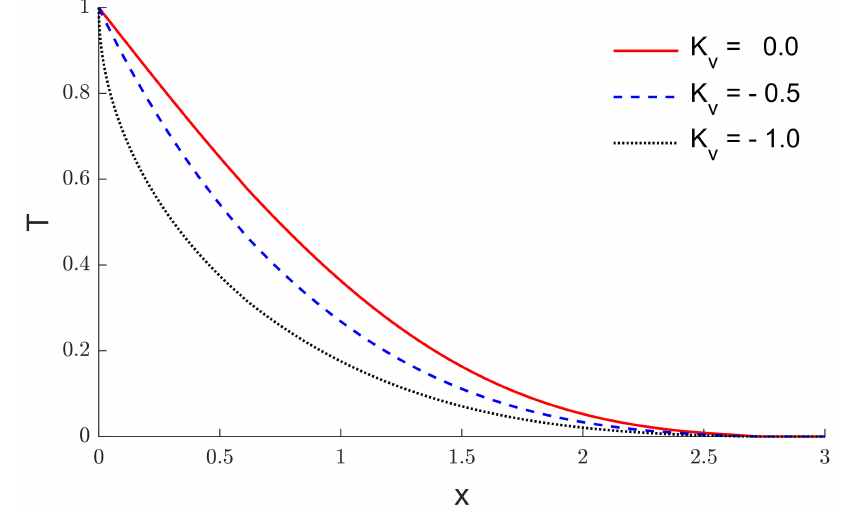
Figure 1. The temperature variation along the distance with three values of K v .